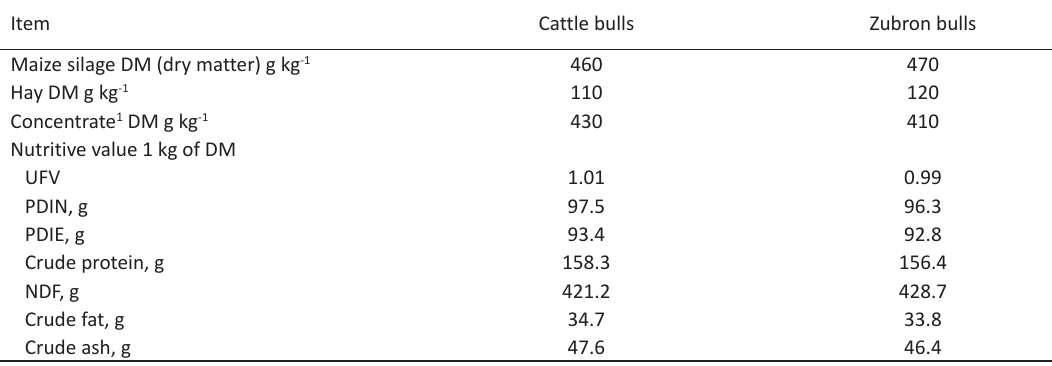
Table 1. Composition and nutritional value of diets Item Cattle